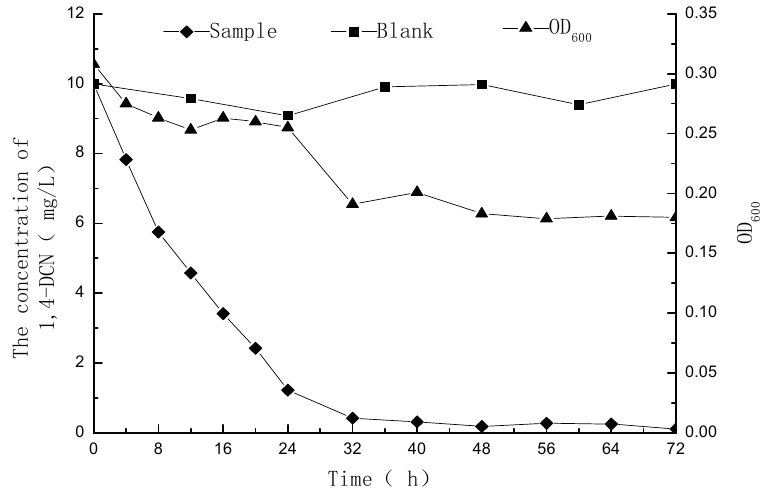
Figure 1. Microbial degradation of 1,4-DCN at an initial concentration of 10 mg/L.